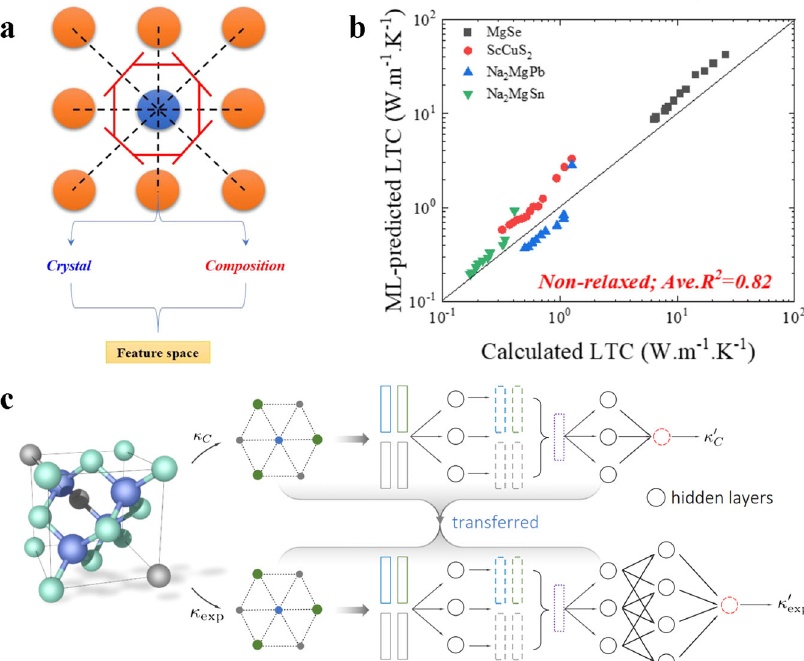
Fig. 3 Machine learning models using the Wigner-Seitz cell or the graph representing the connection of atoms in the crystal as input features. a The Wigner-Seitz cell used to construct the feature space. b Comparisons of the calculated and predicted κ L of 4 compounds in the testing set. a and b are reproduced with permission from ref. 16 . c Schematic of transfer learning based on CGCNN for the prediction of κ L . Here, the crystal structure is converted to a graph, where the nodes represent atoms and the edges connect the neighboring nodes. Reproduced with permission from ref. 51